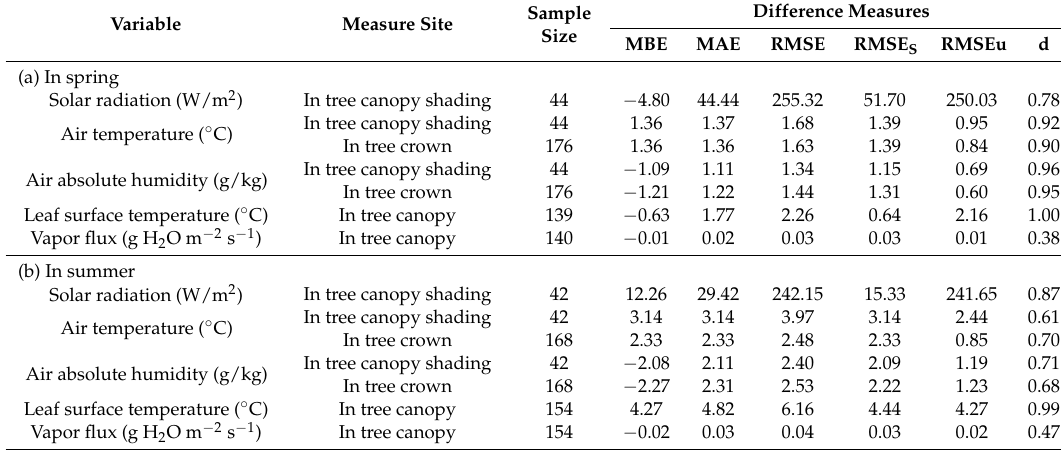
Table 5. Quantitative measures of ENVI-met model performance with observed data in tree canopy shading and in tree crown